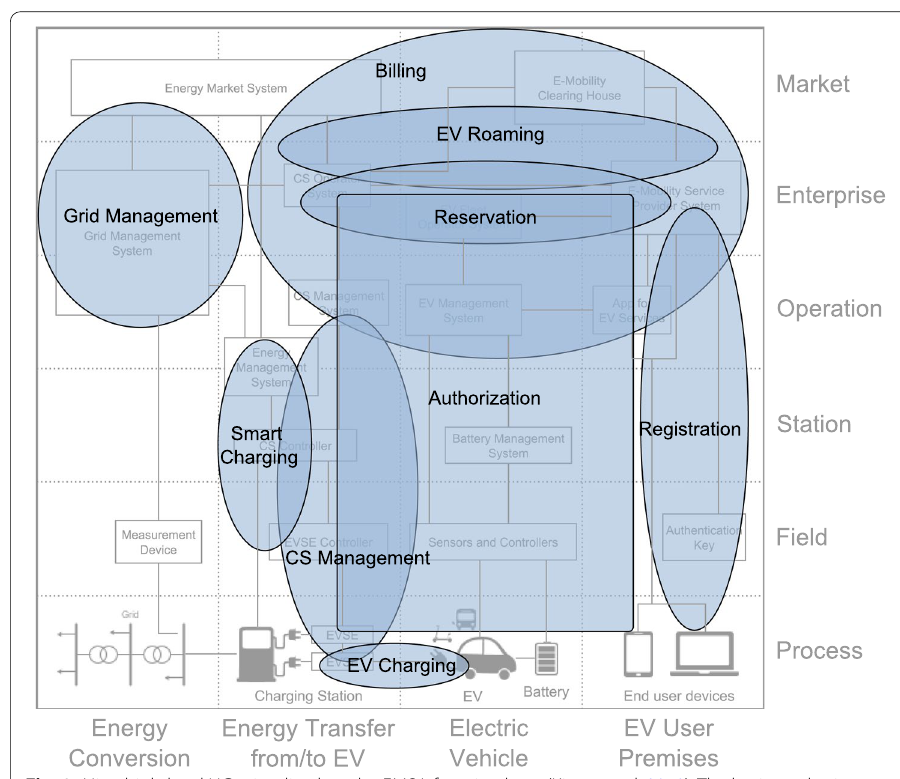
Fig. 2 Nine high-level UCs visualized on the EMSA function layer (Kirpes et al. 2019): The horizontal axis denotes the zones, and the vertical axis denotes the domains. The squares in the background represent the actors, systems and devices of the EV ecosystem, and the blue circles represent the high-level UCs with their involved actors, systems and